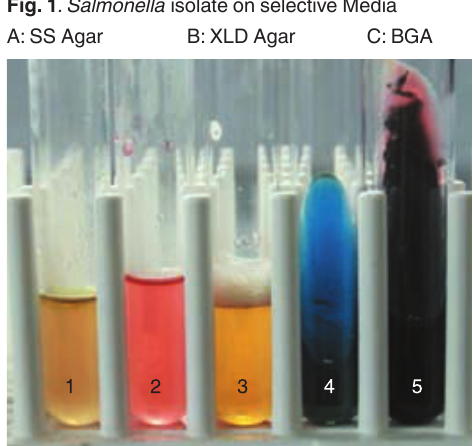
Fig. 1 . Salmonella isolate on selective Media